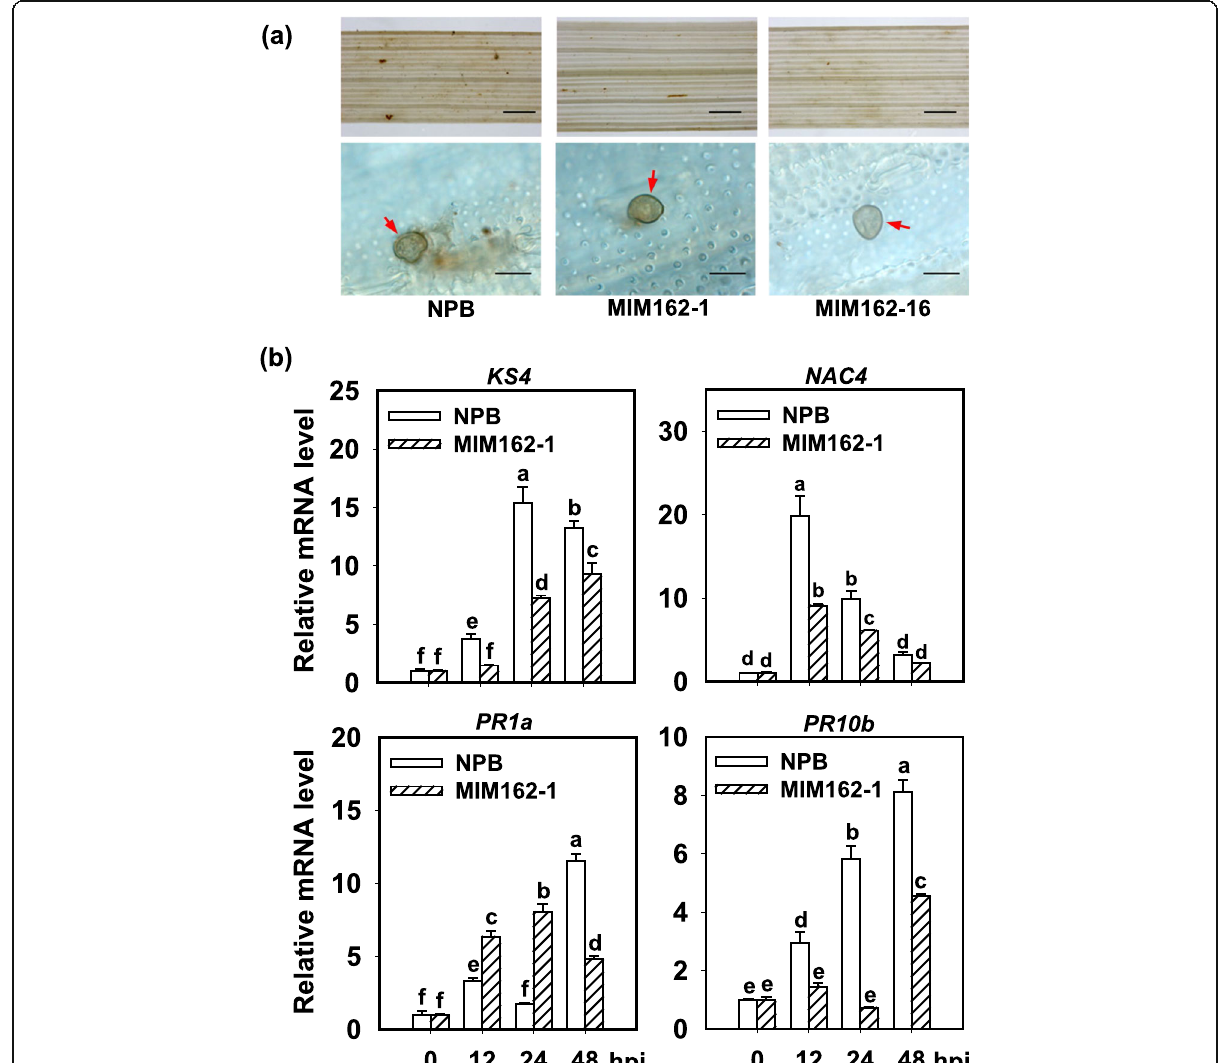
Fig. 5 Blocking Osa-miR162a compromises the induction of disease-related defense responses. a Hydrogen peroxide (H 2 O 2 ) accumulation in wild type (Nipponbare, NPB) and MIM162 at 48 h post-inoculation (hpi) of M. oryzae strain GZ8. The intensity of brown indicates the amounts of H 2 O 2 , which was stained by 3,3 ′ -diaminobenzidine (DAB). The red arrows indicate appressoria formed from conidia. The upper photos were taken with a stereo-microscope, scale bars = 1 mm. The photos at the down portion were taken with a microscope (Zeiss imager A2), scale bars = 40 μ m. b Expression of the defense-related genes (Os KS4, OsNAC4, OsPR1, and OsPR10b ) in NPB and MIM162 following GZ8 inoculation. Rice ubiquitin ( UBQ ) gene was served as an internal reference. The mRNA levels were normalized to that in NPB at 0 hpi. Error bars indicate SD (n = 3). Different letters above the bars indicate significant differences ( P < 0.05) as determined by One-way ANOVA analysis. Similar results were obtained in at least two independent